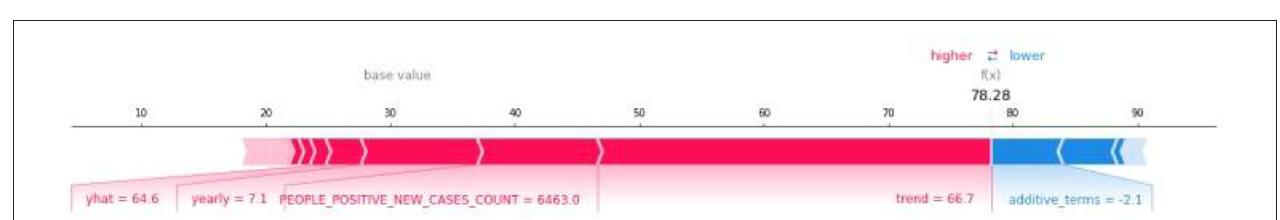
FIGURE 4 | The Shapley additive explanation (SHAP) summary plots about the adjustment to the predicted In OPHS numbers (x-axis) for each of the top-20 features with lagging one (A) , three (B) , seven (C) , and fourteen days (D) .